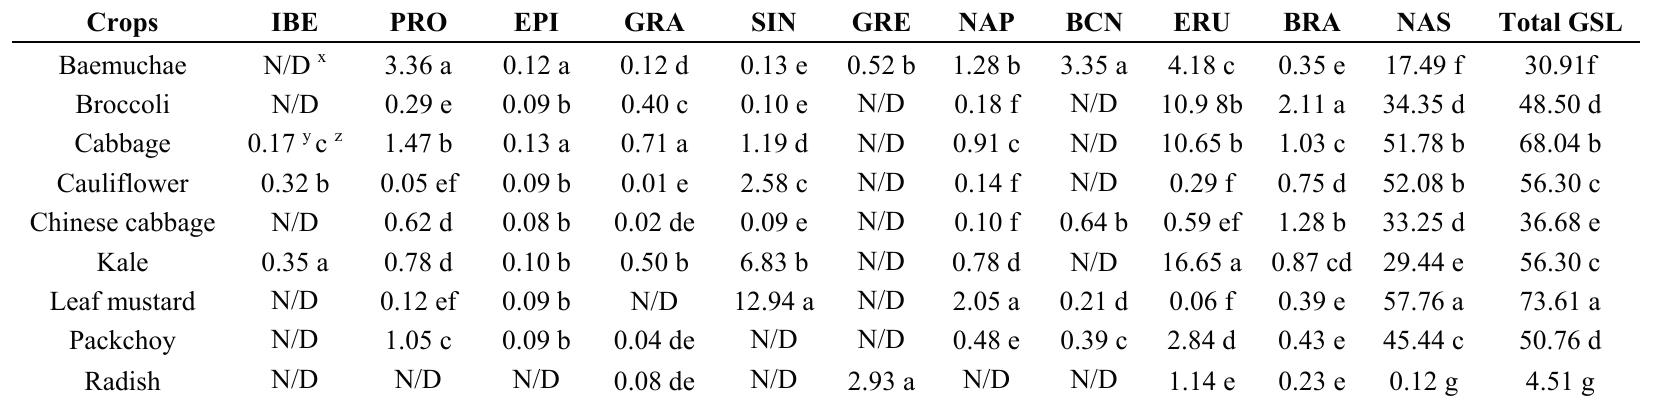
Table 5. Glucosinolate concentration (µmol·g − 1 dry weight) in roots of nine Brassica vegetables.